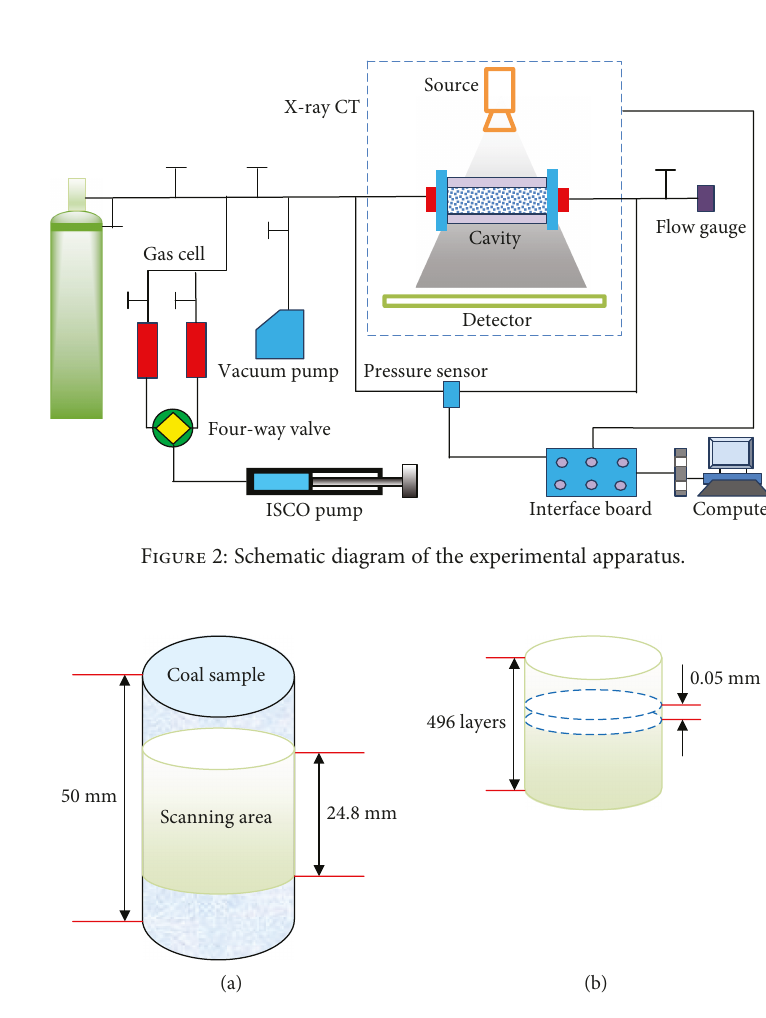
Figure 3: The scan design of the coal sample. (a) Scan area; (b) scan layers.